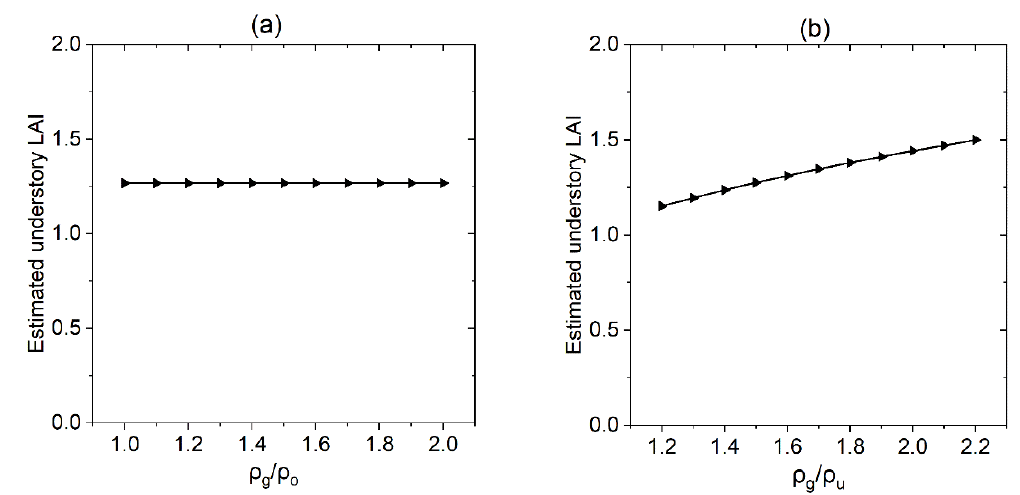
Figure 8. An example of plot-level understory LAI values estimated with ( a ) different ρ g / ρ o values and ( b ) with different ρ g / ρ u values.